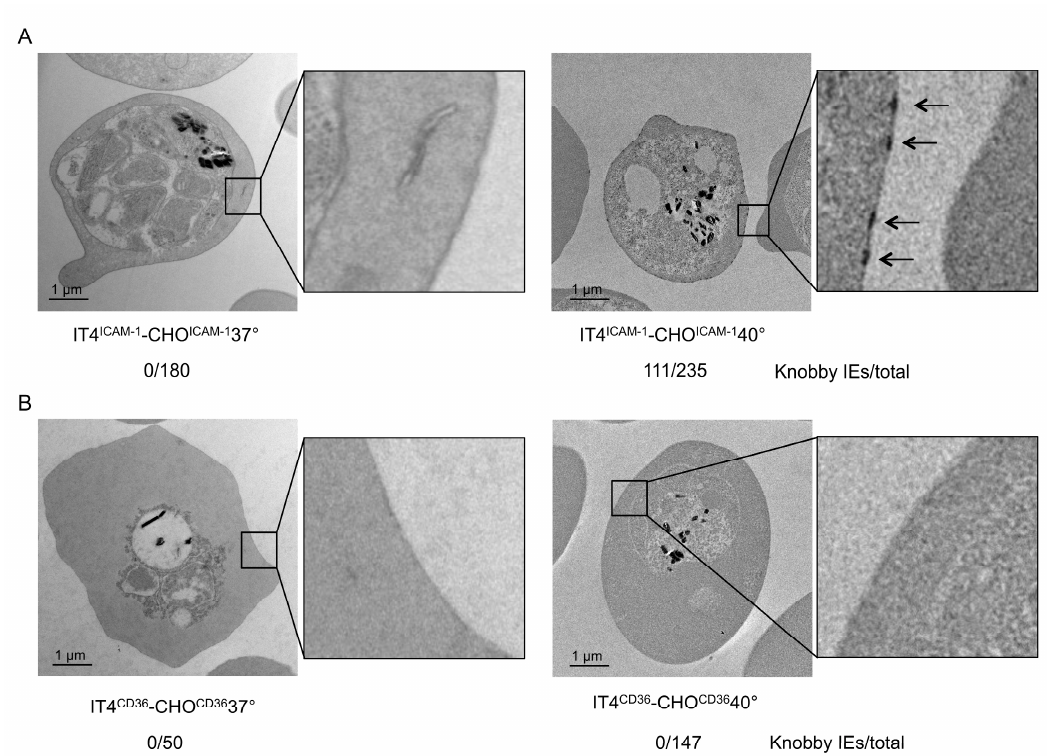
Figure 4. Electron micrographs of IEs enriched for binding to ( A ) CHO ICAM-1 at 37 ◦ C (IT4 ICAM-1 CHO ICAM-1 37 ◦ ) and 40 ◦ C (IT4 ICAM-1 CHOO ICAM-1 40 ◦ ), and to ( B ) CHO CD36 at 37 ◦ C (IT4 CD36 CHO CD36 37 ◦ ) and 40 ◦ C (IT4 CD36 CHOO CD36 40 ◦ ). Number of knobby IEs relative to total number of analyzed IEs is indicated. Table 3. Normalized expression level of various genes of IT4 ICAM-1 CHO ICAM-1 40°, IT4 CD36 CHO CD36 40° compared to IT4 NE. determined using qPCR. For read counts (RNAseq) of IT4 NE , IT4 ICAM-1 CHO ICAM-1 37° and IT4 CD36 CHO CD36 37° (* see [33]).